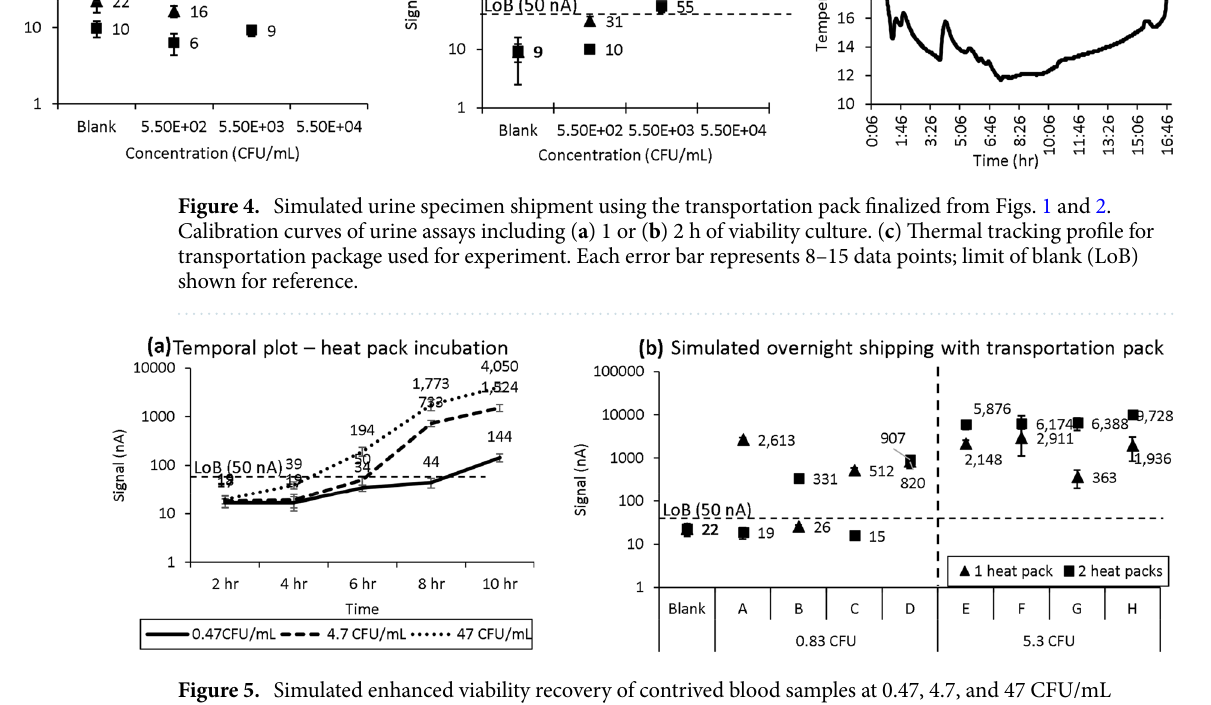
Figure 5. Simulated enhanced viability recovery of contrived blood samples at 0.47, 4.7, and 47 CFU/mL tested every 2 h after storage in a thermal bag with 2 heat packs. ( a ) All blood samples reported positive after 10 h of simulated transportation time. ( b ) Simulated overnight shipping with blood samples contrived at 0.83 and 5.3 CFU/mL with either 1 or 2 heat packs. Each error bar represents 5–15 data points; limit of blank (LoB) shown for reference.